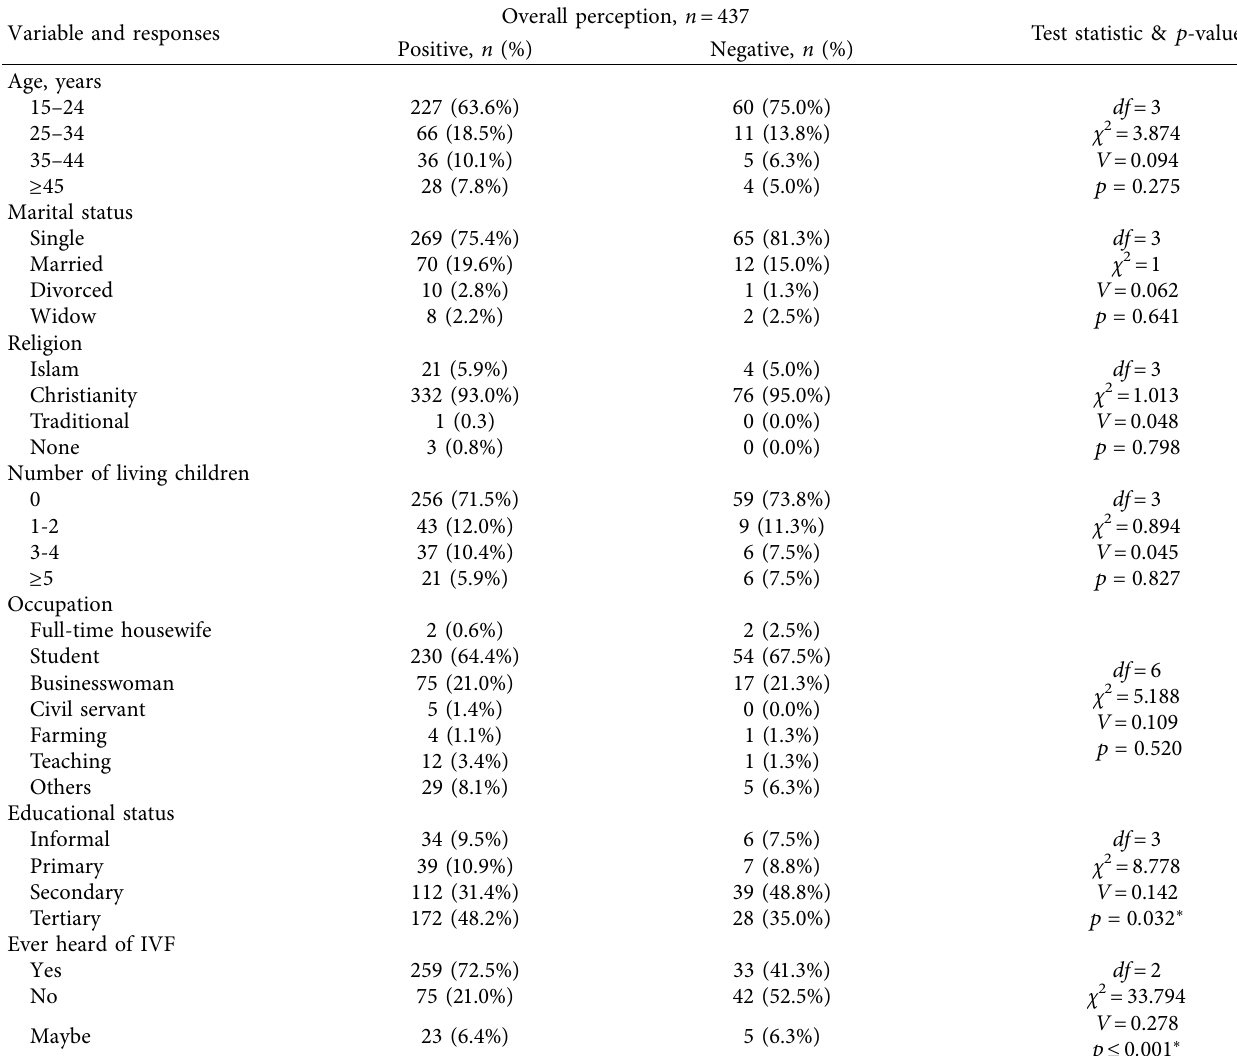
Table 7: Chi-Square test of association between respondents’ background characteristics by their perception of IVF services. Variable and